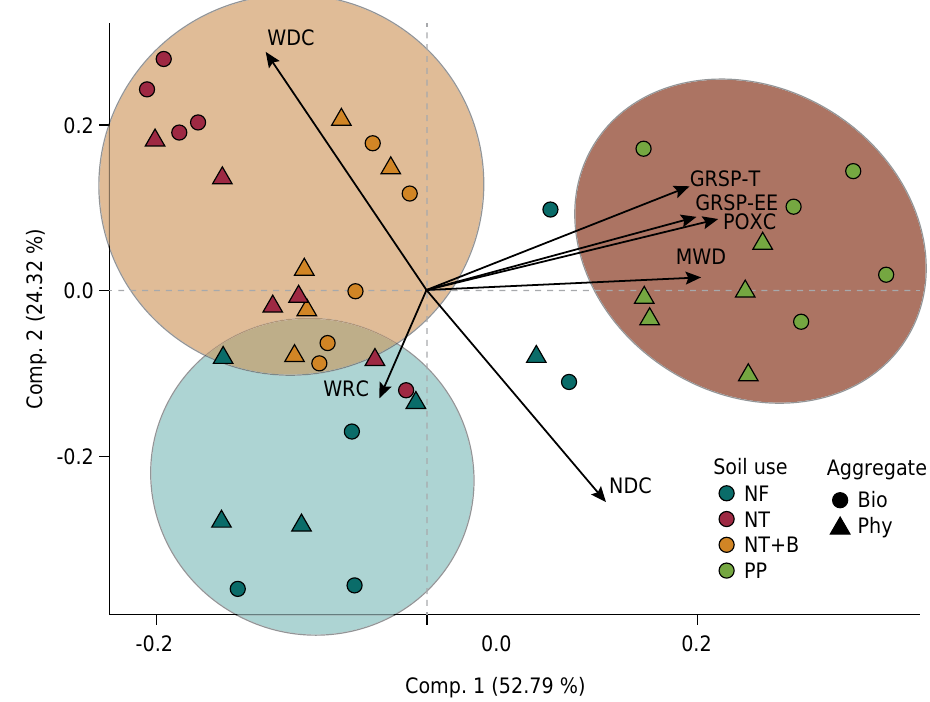
Figure 4. Principal component analysis integrating the aggregation state and the organic fractions associated with the stability of biogenic (Bio) and physicogenic (Phy) aggregates from areas under management systems in the 0.05-0.10 m layer, subtropical region of Brazil. PP: Permanent pasture; NT: No-tillage system; NT+B: No-tillage + Brachiaria system; NF: Atlantic Forest biome vegetation; MWD: mean weight diameter; WDC: water-dispersible clay; WRC: water-re-flocculable clay; NDC: non-dispersible clay; POXC: labile organic carbon; GRSP-EE: easily extractable glomalin; and GRSP-T: total